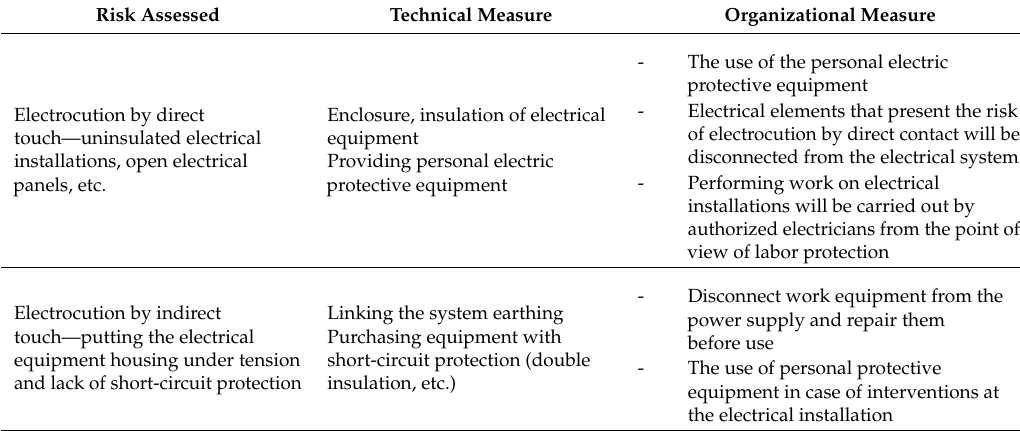
Table 5. Prevention and protection plan in case of